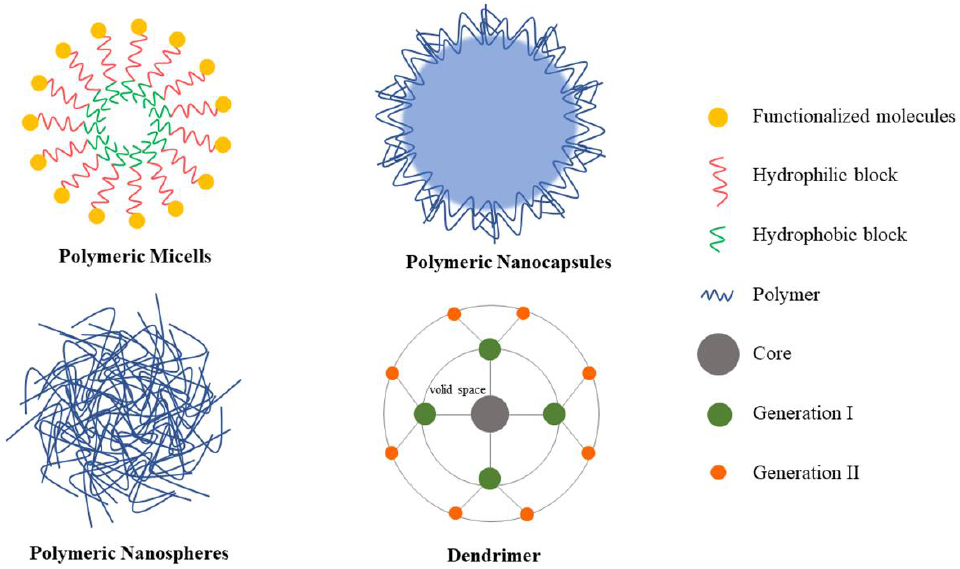
Figure 7. Types of polymer nanoparticles used for siRNA pulmonary delivery.